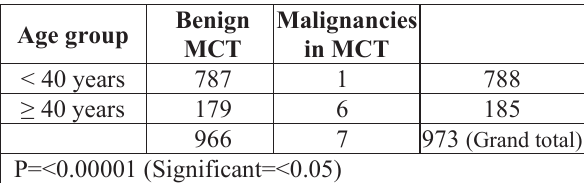
Table-5: Age Group and Malignancies